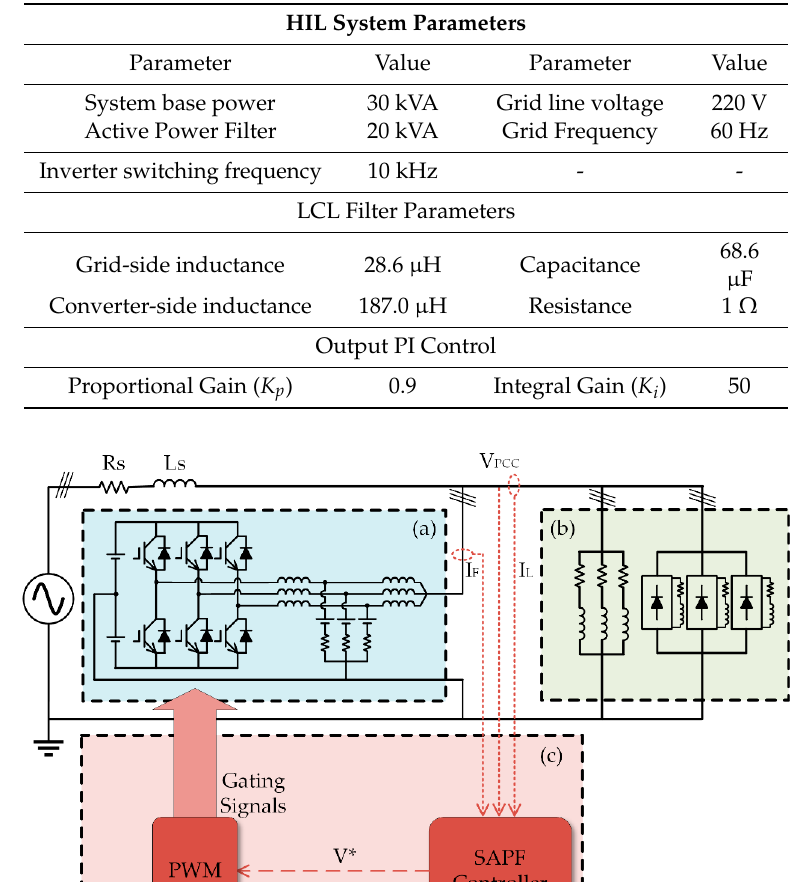
Table 6. Test-bench parameters.